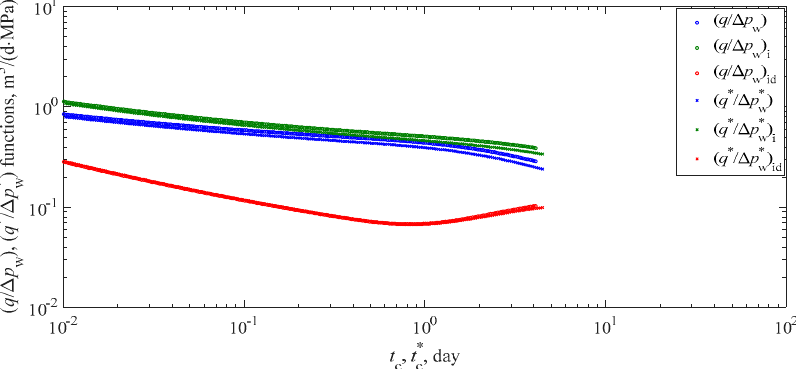
Figure 12. Normalized rate functions and modified normalized rate functions for CRP case of q = 10m 3 /d.